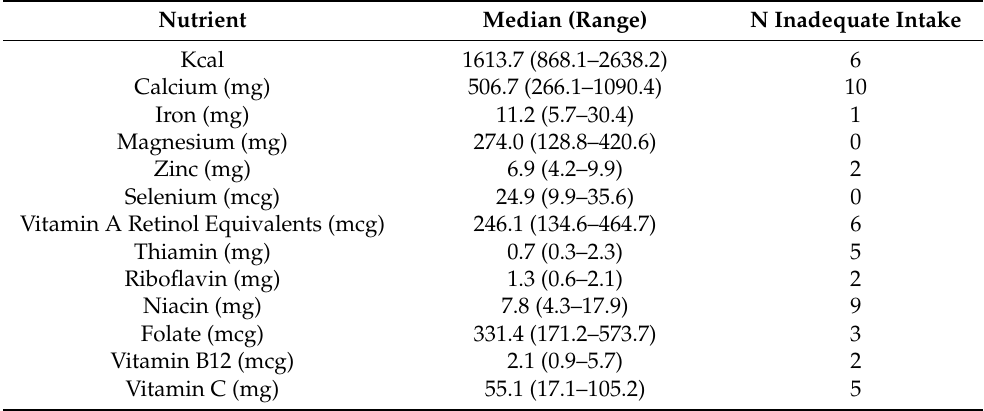
Table 1. Description of nutrient intakes over three days of reporting during the COVID-19